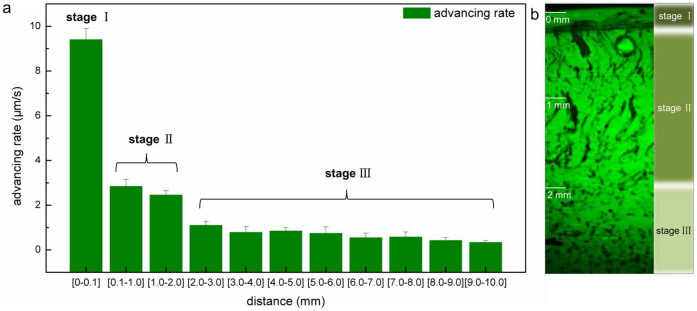
Three stages of gelation process.(a) Average advancing rate of interface at different distance regions, error bars indicate standard errors for n = 5, (b) CLSM image of corresponding hydrogel on the longitudinal section.